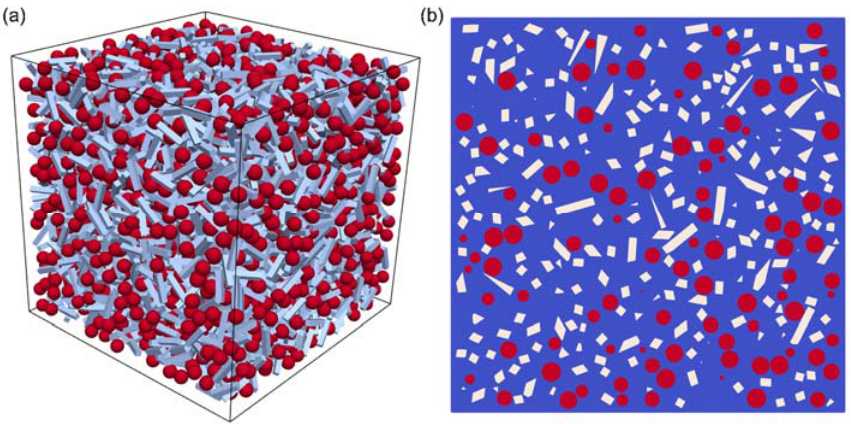
Figure 7 . Modeled microstructure of sample C12–SiOC–1600: ( a ) three ‐ dimensional representation of a 100 × 100 × 100 nm 3 volume and ( b ) two ‐ dimensional cross ‐ section of ( a ). Red spheres represent β‐SiC nanoparticles (5 nm diameter), and white rods represent the segregated carbon phase.